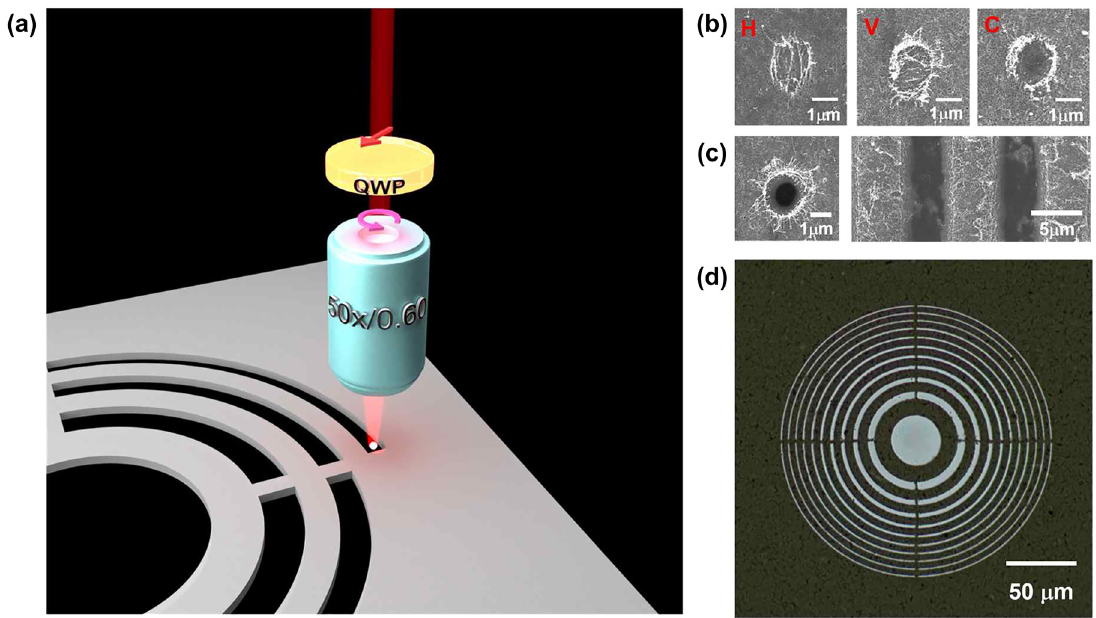
Figure 2: Fabrication of FZP on CNT network film using direct laser writing. (a) Schematic illustration of fabricating bridged-Fresnel zone plate on the CNT network film via direct laser writing. (b) Polarization-dependent ablation of CNT network film (H, V, and C stand for horizontal, vertical, and circular polarization of incident pulse, respectively). (c) Spot and line fabrications on the CNT network film, (d) Microscopic image of the bridged-Fresnel zone plate ( N = 21) fabricated on CNT network